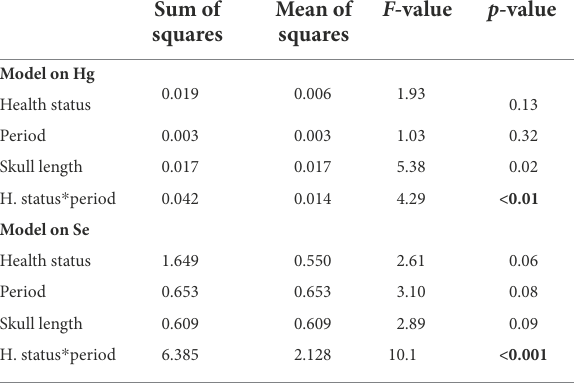
Significant p -values are shown in